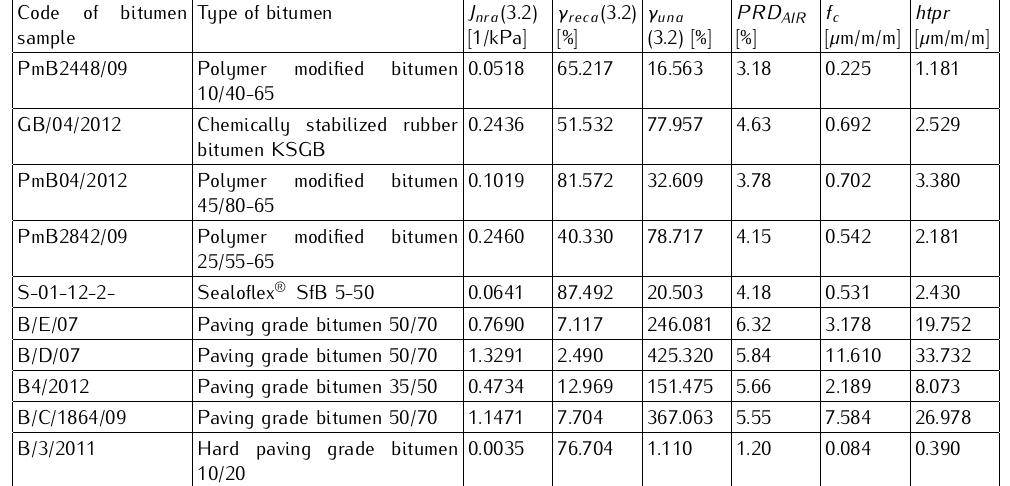
Table 3. Summary of the permanent deformation parameters of AC 16 asphalt mix and binders Code of bitumen